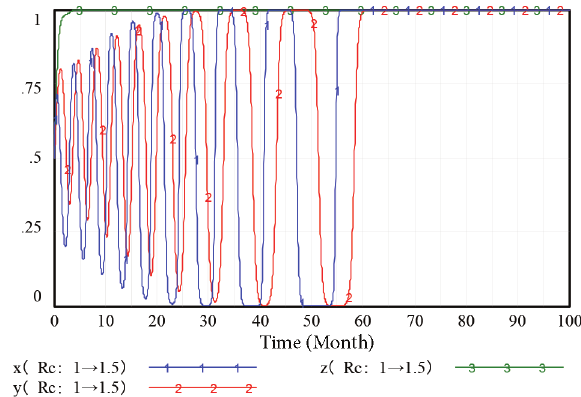
Figure 8. Game results under penalty increase of CSE ( P c )